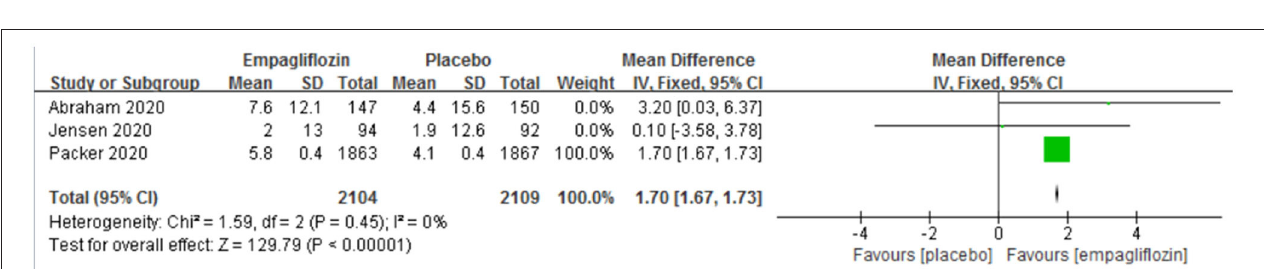
FIGURE 5 | Effect of empagliflozin on the change in N-terminal pro-brain natriuretic peptide (NT-proBNP) from baseline.